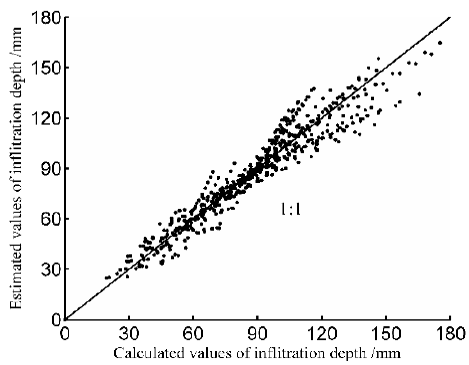
Figure 5. Comparisons of the estimated infiltration depths determined using Equation (12), and calculated values based on the infiltration parameters in Table 2.